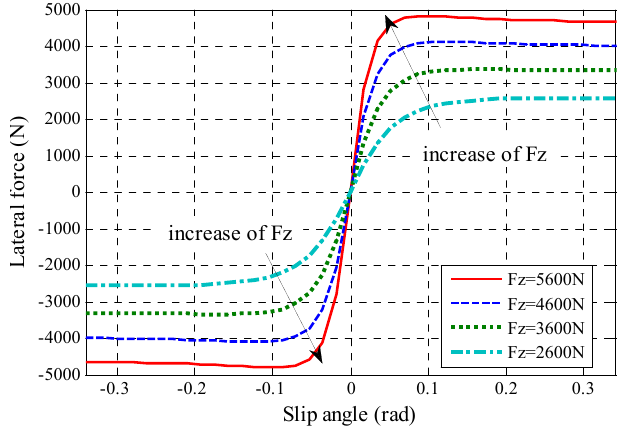
Figure 6. Influence of vertical force on tire lateral force.